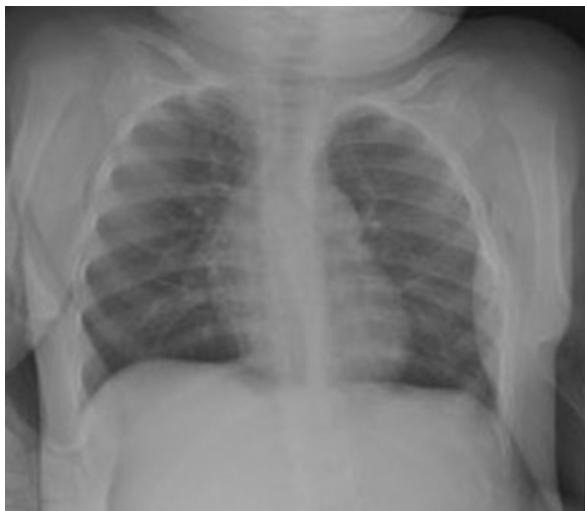
Fig. 2 Chest X-ray at 1 year